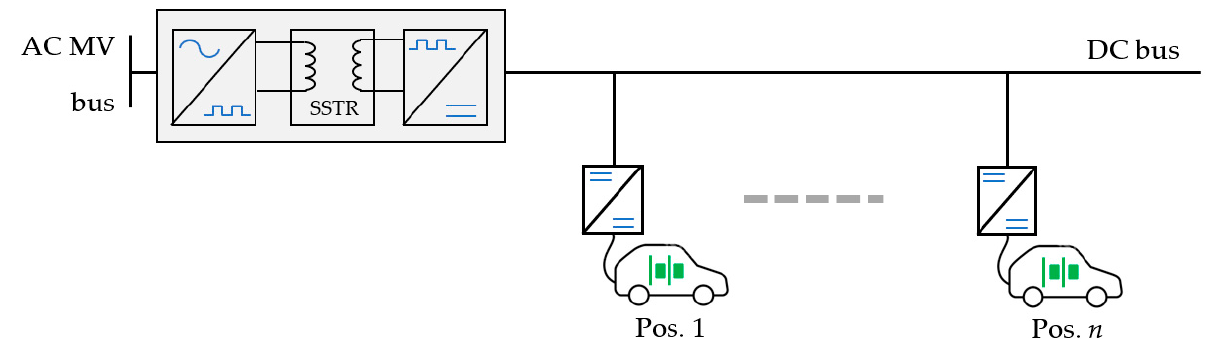
Figure 1. Scheme of the UFC station connected to an MV network.